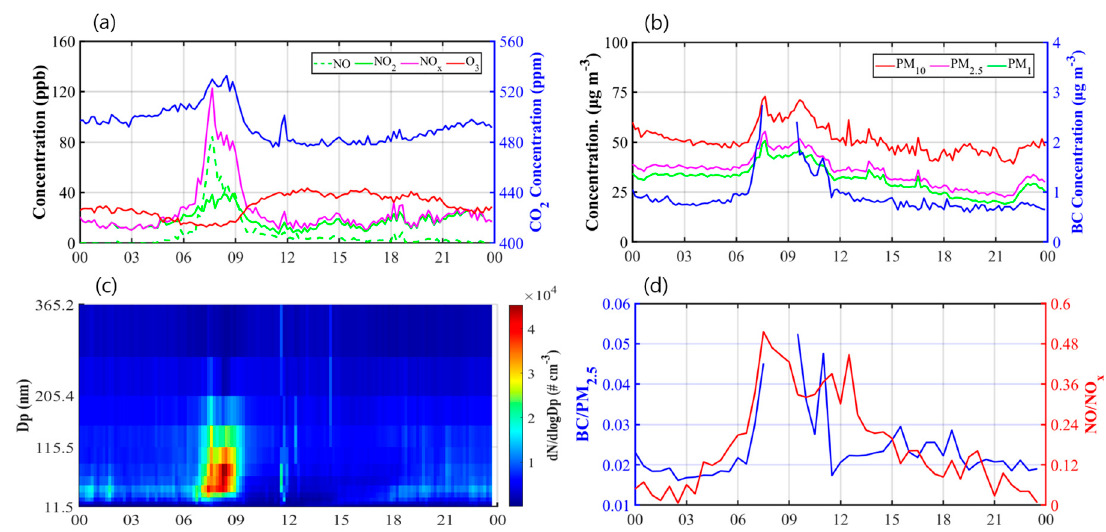
Figure 3. Time series of ( a ) gaseous pollutant (NO x , NO, NO 2 , O 3 , and CO 2 ) concentrations, ( b ) particulate pollutant (PM 10 , PM 2.5 , PM 1 , and BC) concentrations, ( c ) size distributions of UFPs, and ( d ) concentration ratios (BC / PM 2.5 and NO / NO x ) measured at the stationary measurement location averaged over the P1D and P2D periods. The average time interval is 10 min except for the concentration ratios (30